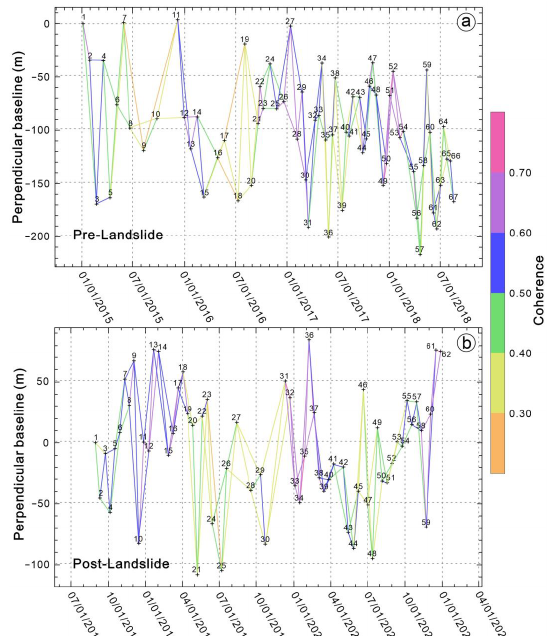
Figure 3. Baseline plot of Sentinel-1 data: the colors of the lines indicate the coherence of each inter- ferogram pair.